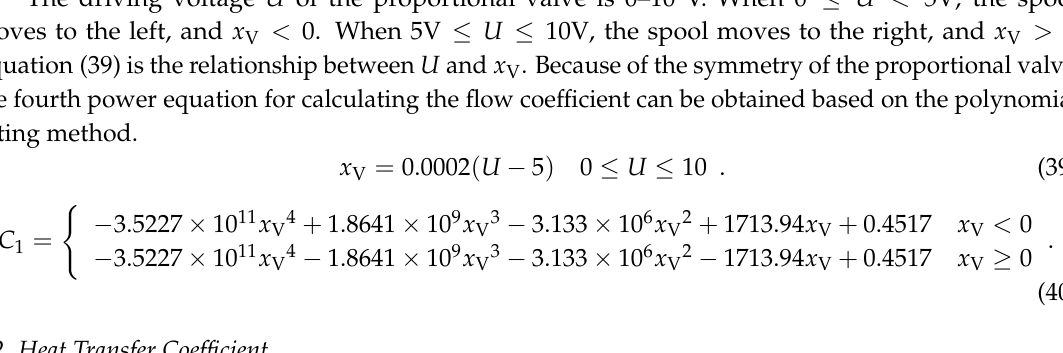
C under different driving voltages. 1